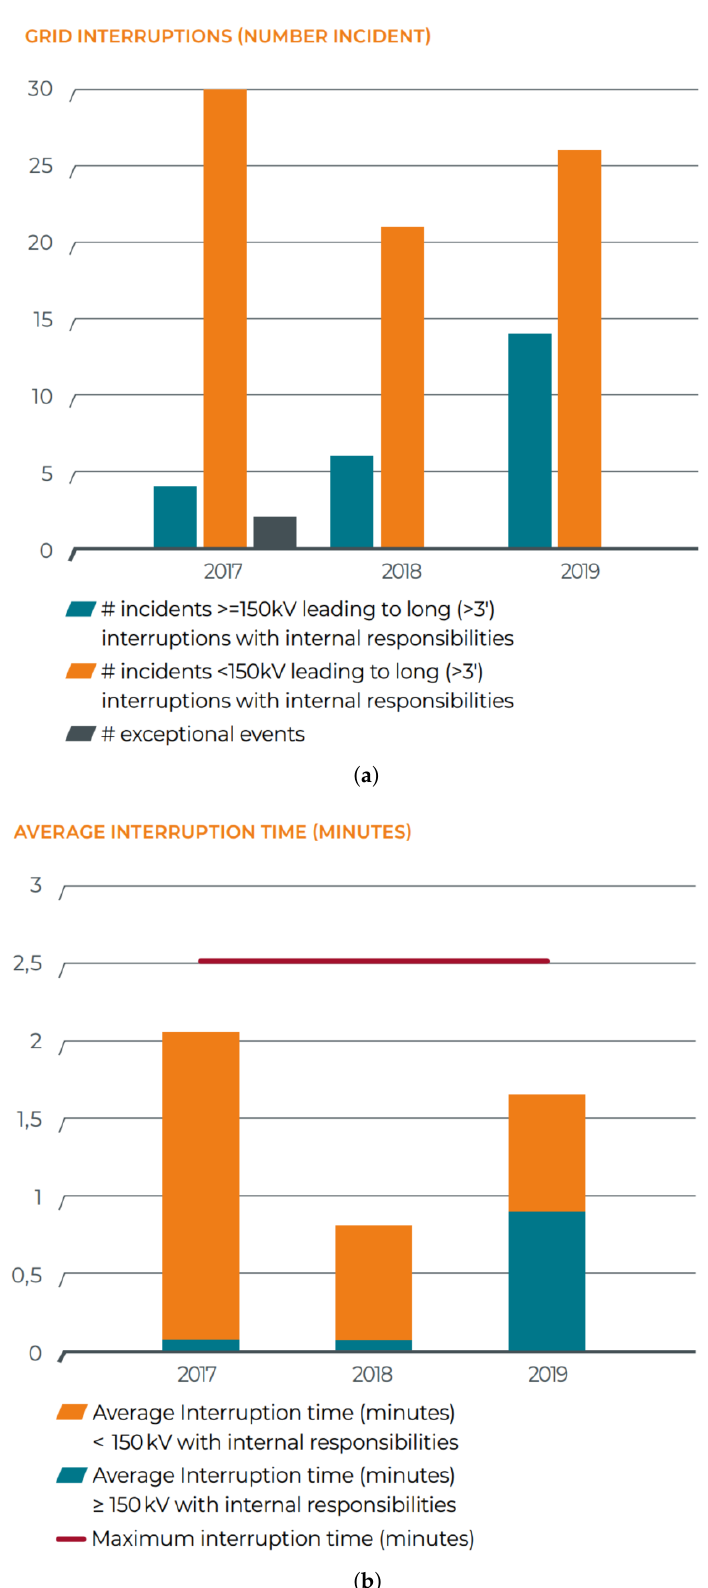
Figure 21. Occurred incidents in the Belgian power system at lower and higher than 150 kV for which TSO was responsible [171]: ( a ) Number of incidents. ( b ) Duration of